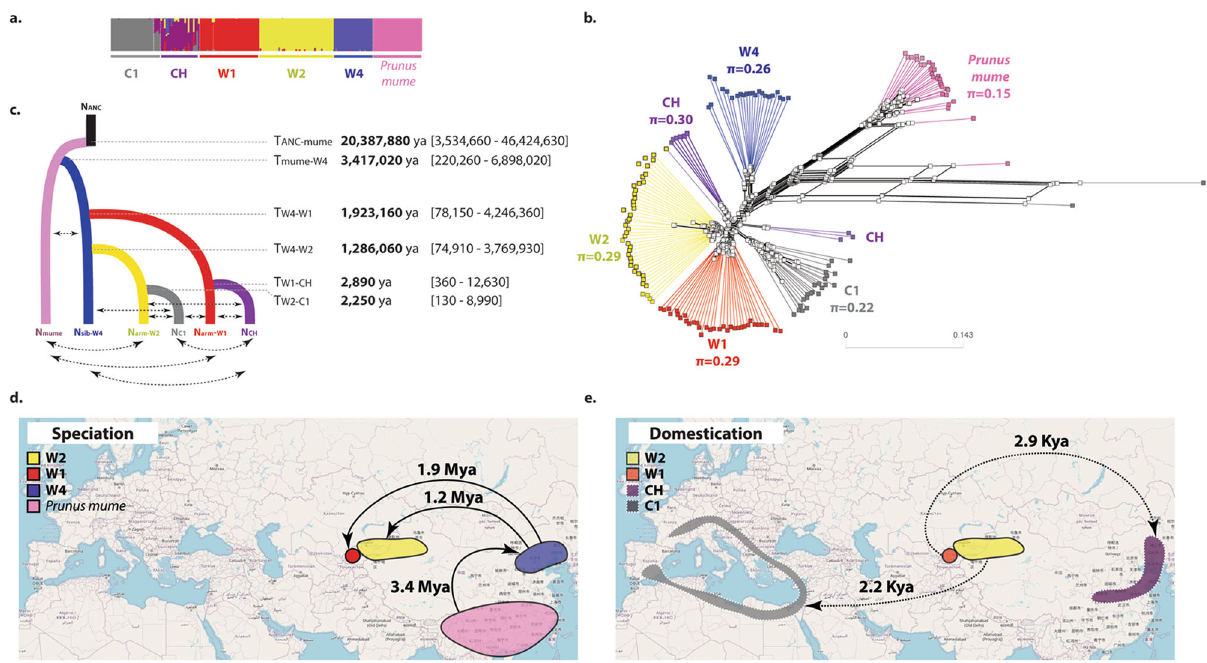
Fig. 5 Inference of independent domestication events of apricot, with divergence in the face of gene fl ow, using random-forest approximate Bayesian computation combined with coalescent-based simulations. a fastSTRUCTURE barplot for the pruned dataset used for random-forest approximate Bayesian computation (ABC-RF) computations, excluding Prunus brigantina , clonemates and siblings, as well as recently admixed individuals. b Splitstree for the pruned dataset used for ABC-RF computations, branches being colored according to the clusters identi fi ed with fastSTRUCTURE. Values under population labels are the average number of nucleotide differences between genotypes ( π ). c Most likely scenario of apricot domestication inferred from ABC-RF. Parameter estimates are shown, with their 95% con fi dence interval in brackets. Arrows represent migration between two populations. Associated maps depicting the speciation ( d ) and domestication ( e ) histories of apricots, with the approximate periods of time, drawn from ABC inferences. For all panels: W4 in blue: wild Prunus. sibirica ; W1 in red and W2 in yellow: wild Southern and Northern Central Asian P. Armeniaca , C1 in grey and CH in purple: European and Chinese cultivated P. armeniaca , respectively, and P. mume in pink. Population names correspond to the ones detected with fastSTRUCTURE. Maps are licensed as Creative Commons. Source data are provided as a Source Data fi